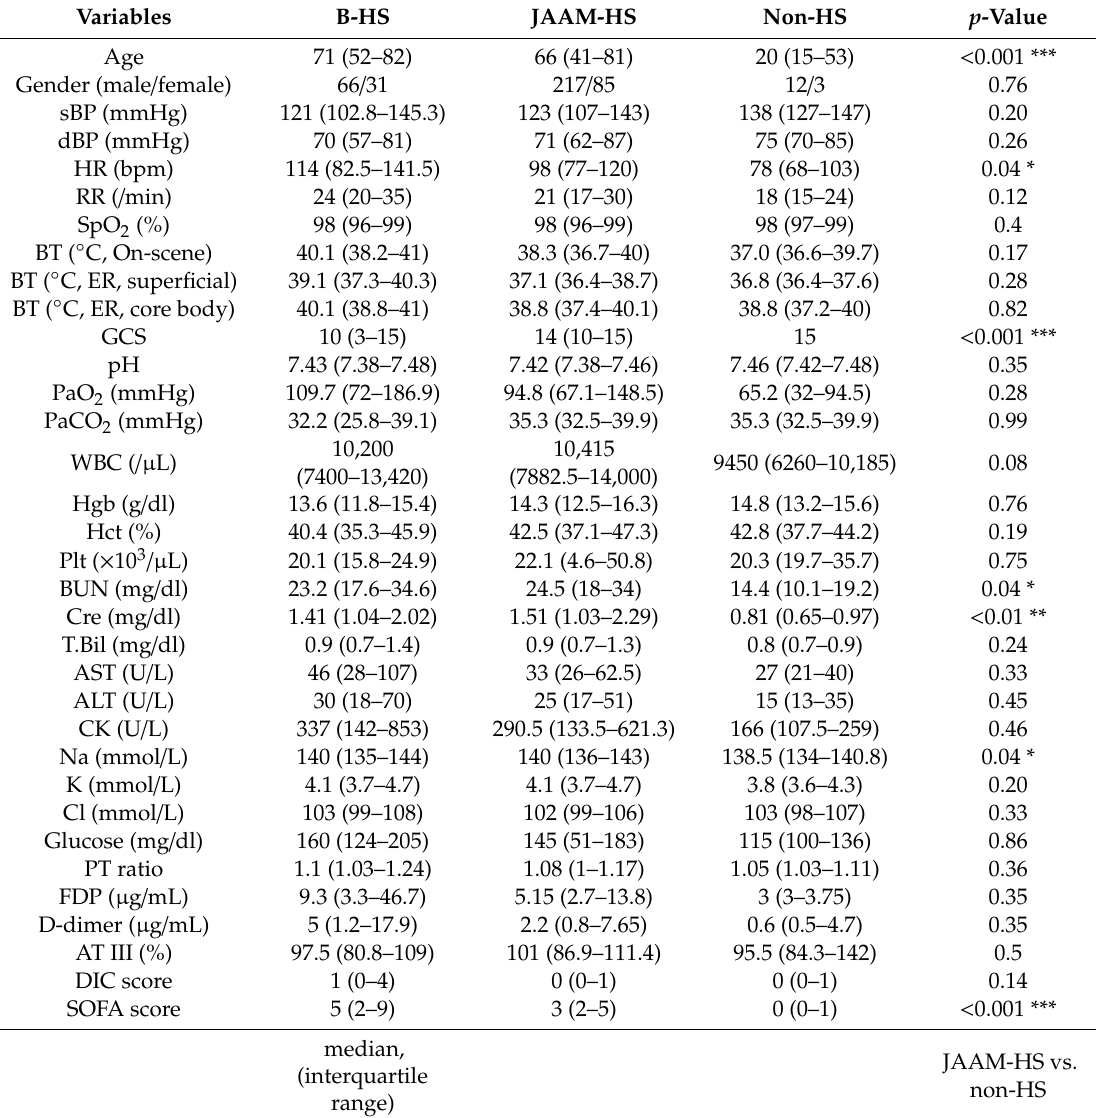
Table 2. Characteristics of the B-HS, JAAM-HS, and non-HS